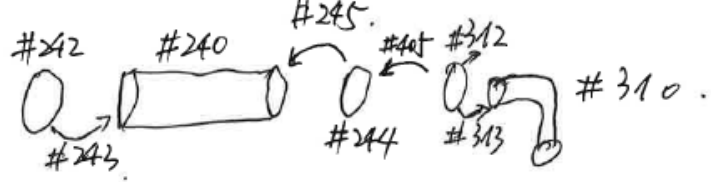
Figure 5. Another example for a code interpretation question—indoor utility network.